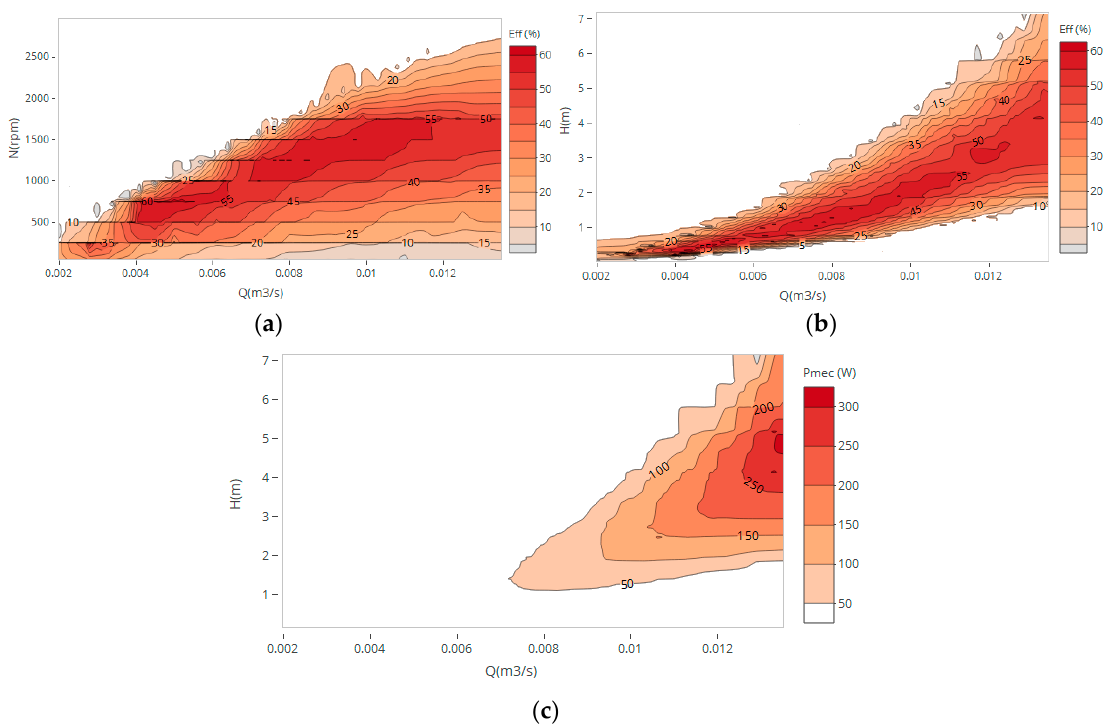
Figure 2. Hill charts obtained from experimental tests: ( a ) Efficiency vs. flow and rotational speed; ( b ) Efficiency vs. flow and head; ( c ) Mechanical power vs. flow and head.